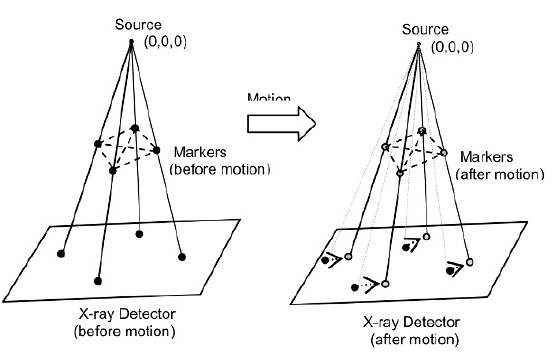
Figure 13. Source, Detector and Markers showing motion.